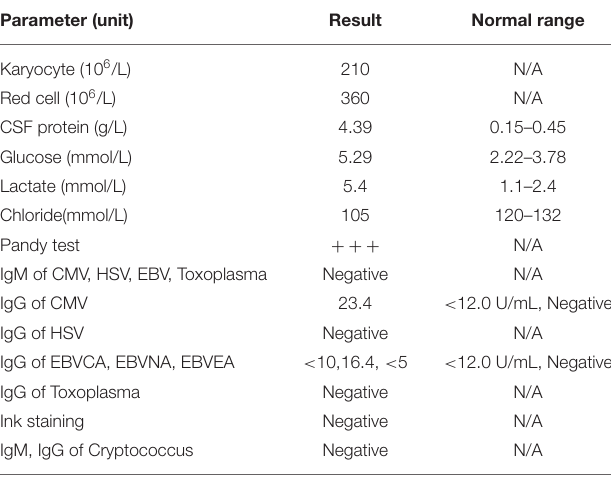
TABLE 1 | The data of diagnostic workup for the cerebrospinal fluid (CSF) sample after 10 days of initial treatment. Parameter (unit) Result Normal range